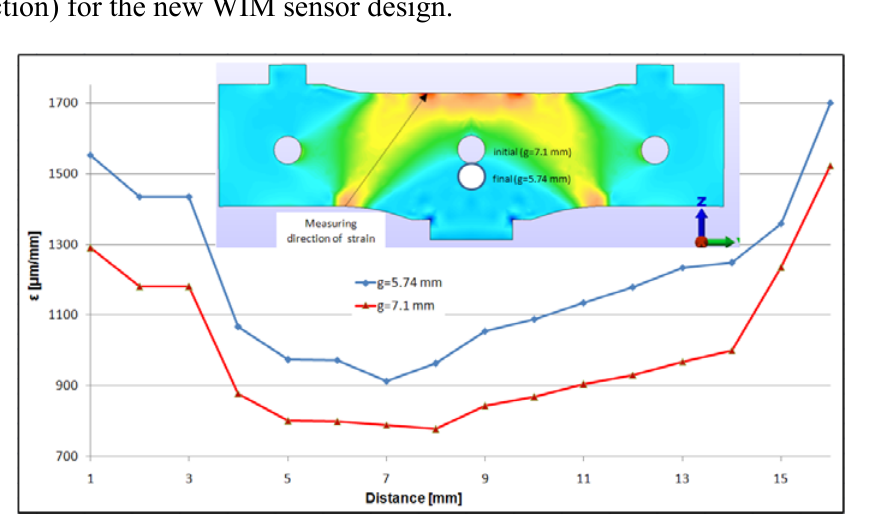
Figure 10. Central elastic plate—Strain variation on the measurement direction (strain gage direction) for the new WIM sensor